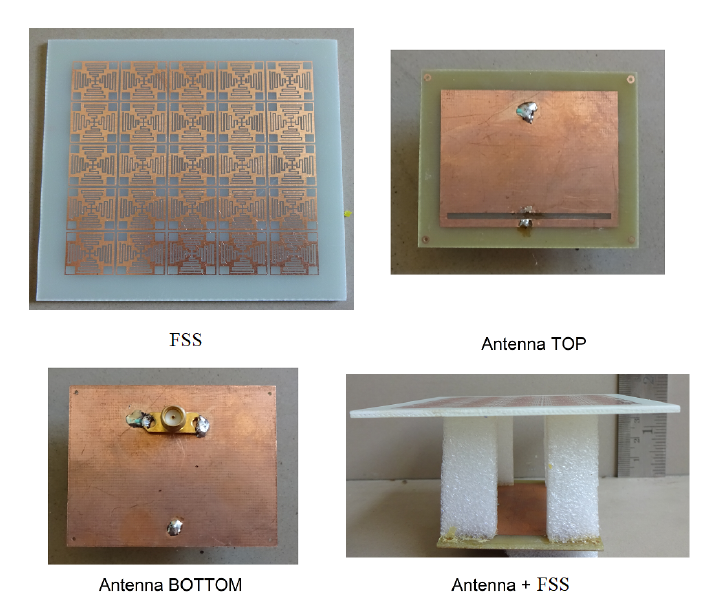
Figure 12. Prototypes of the superstrate integrated antenna.